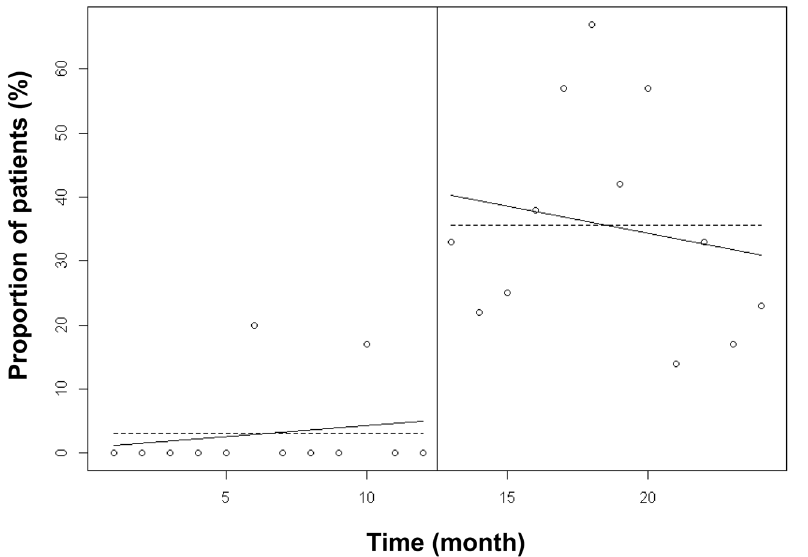
Figure 6. Proportion of patients with a prescribed nitrogen intake between 80 and 120% of recommended intake. The linear trend of adequately targeted nitrogen intake ordering over one year was not significantly different (p=0.18) after than before implementation of the computer help. This suggests that improvement of nitrogen ordering did not decrease over time after the implementation of the computer help.